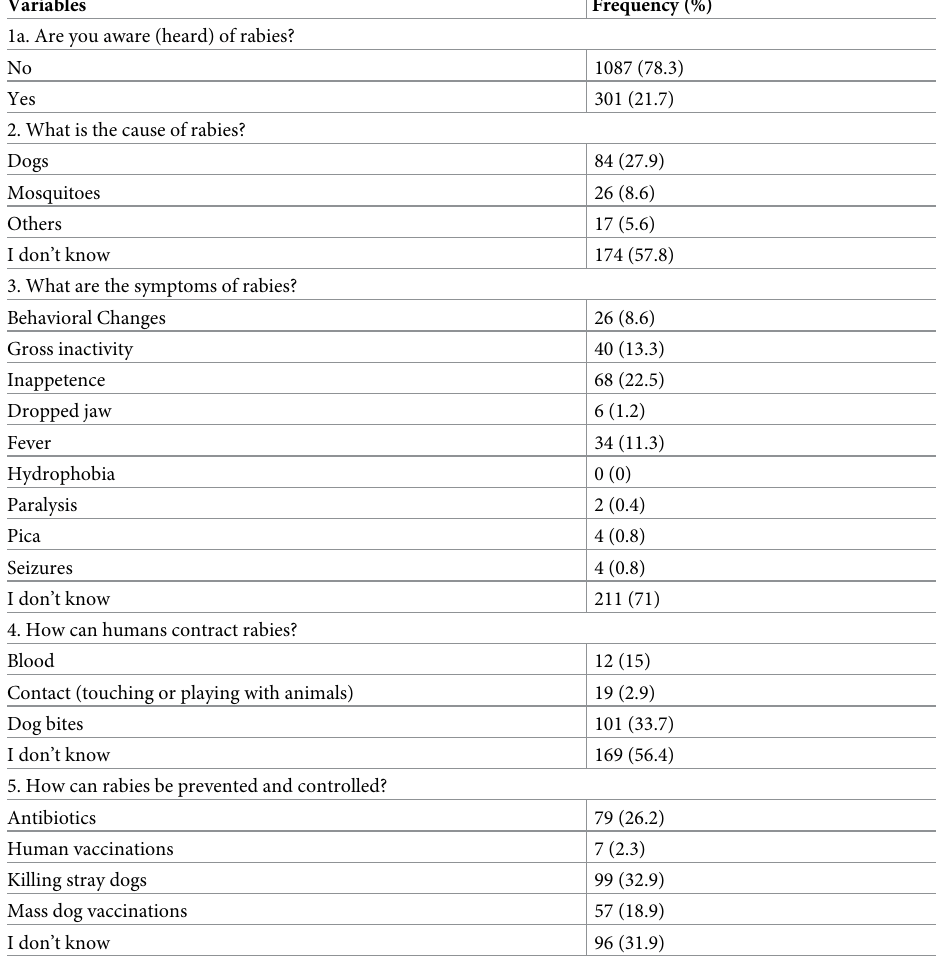
Table 2. Awareness and knowledge of canine rabies among pupils under 15 years in Kwara State,